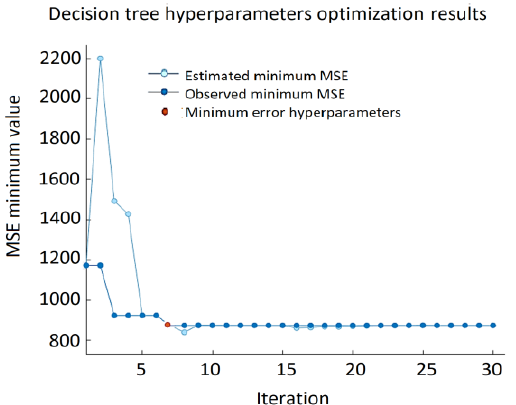
Figure 15. Minimum MSE during DT hypermeters’ optimization process.